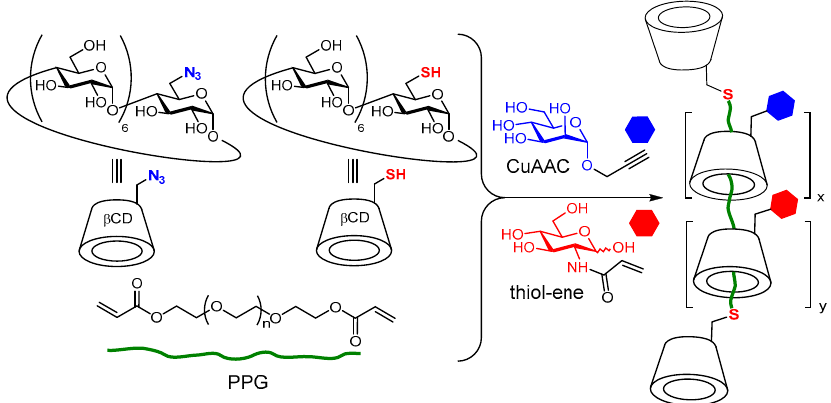
Figure 9. One-pot multicomponent synthesis of polyrotaxane-based heteroglycopolymers developed by Gao, Chen and coworkers [68]. CuAAC, copper(II) azide-alkyne cycloaddition; PPG, polypropylene glycol.